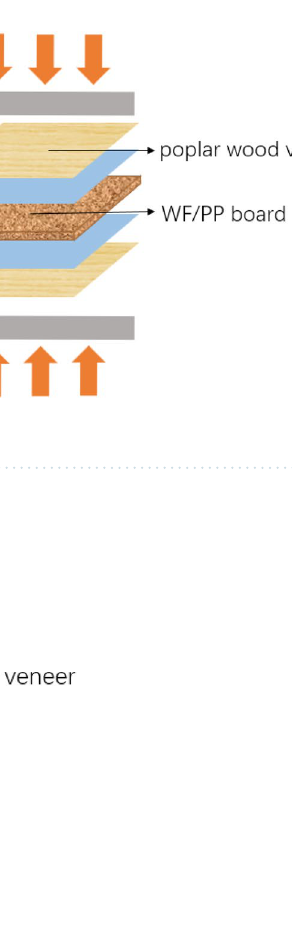
Figure 2. Bonding strength test of the veneered WF/PP composite was